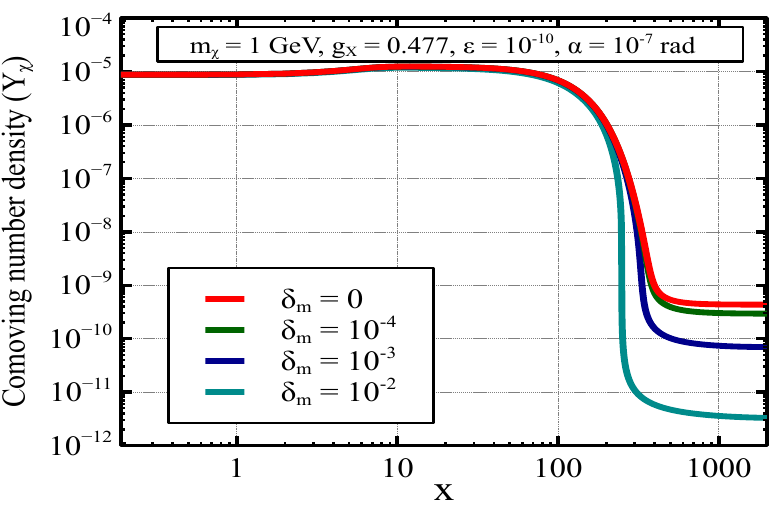
Figure 11 . Variation of Y χ with x for different values of δ m